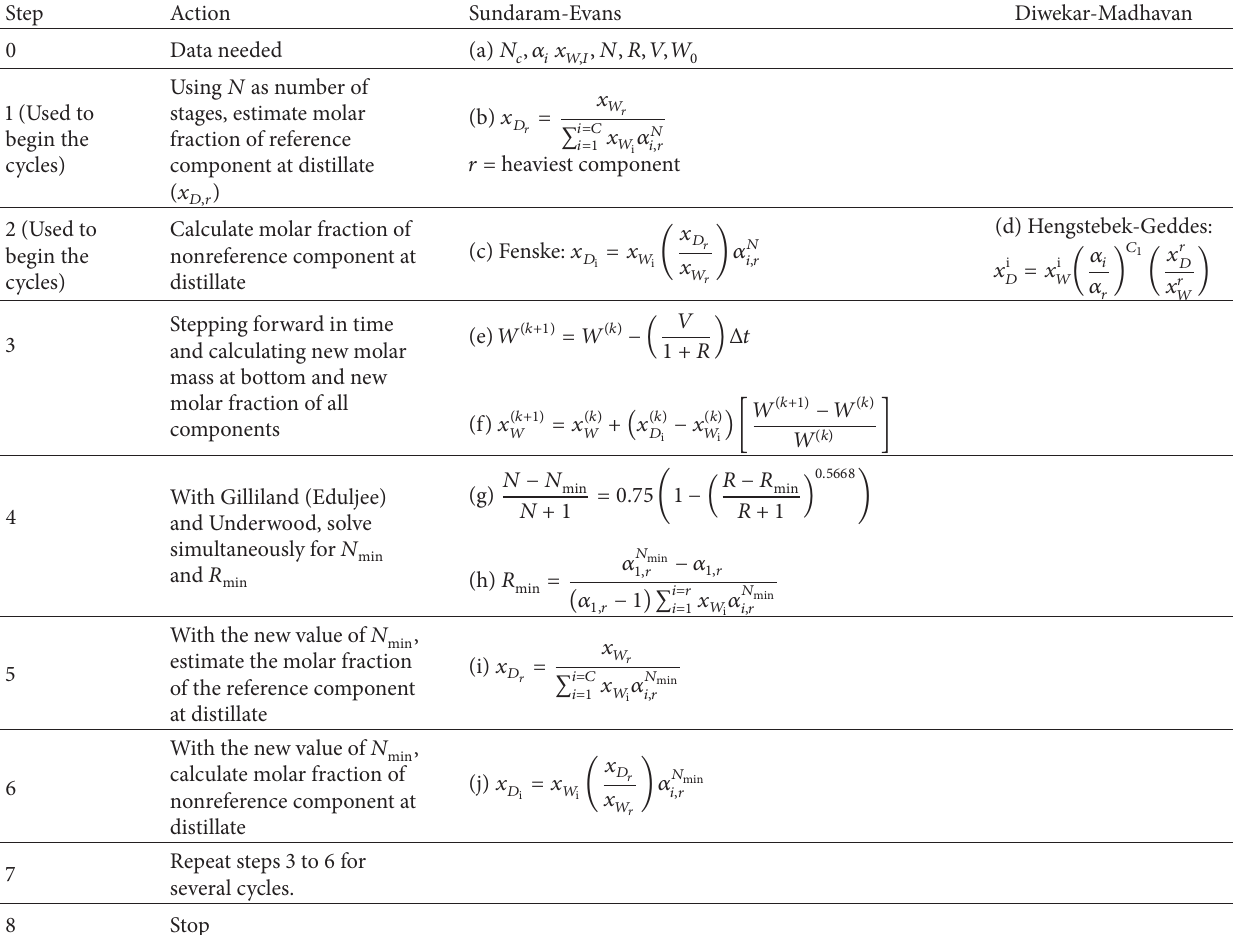
Table 2: Actions and equations used in batch distillation column operating at constant